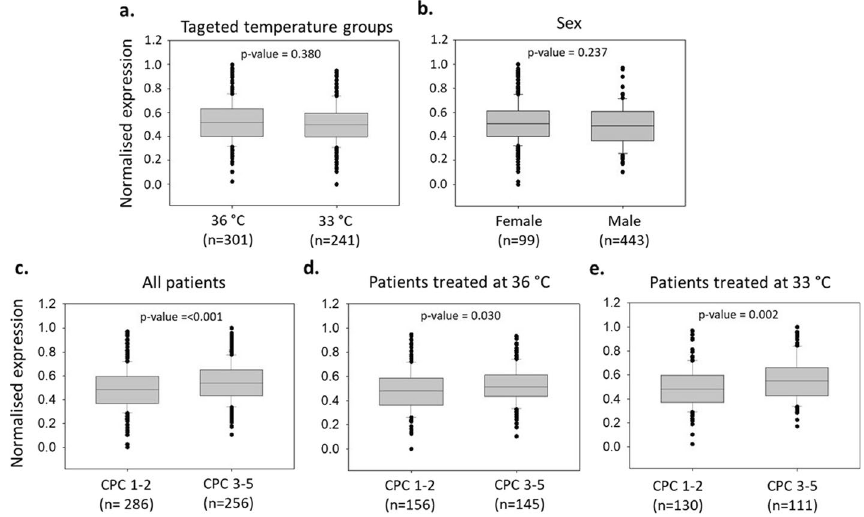
Fig. 2 CircNFAT5 expression levels in 542 patients of the TTM‑trial. CircNFAT5 levels were compared according to the temperature regimen and regardless of the neurological outcome (a) , between females and males (b), between good (CPC 1–2) and poor (CPC 3–5) neurological outcome regardless of the temperature regimen (c), and separately in patients treated at 36 °C or 33 °C (d, e) . The expression levels of circNFAT5 were normalized, log2 transformed and scaled. p ‑values are from Mann–Whitney U